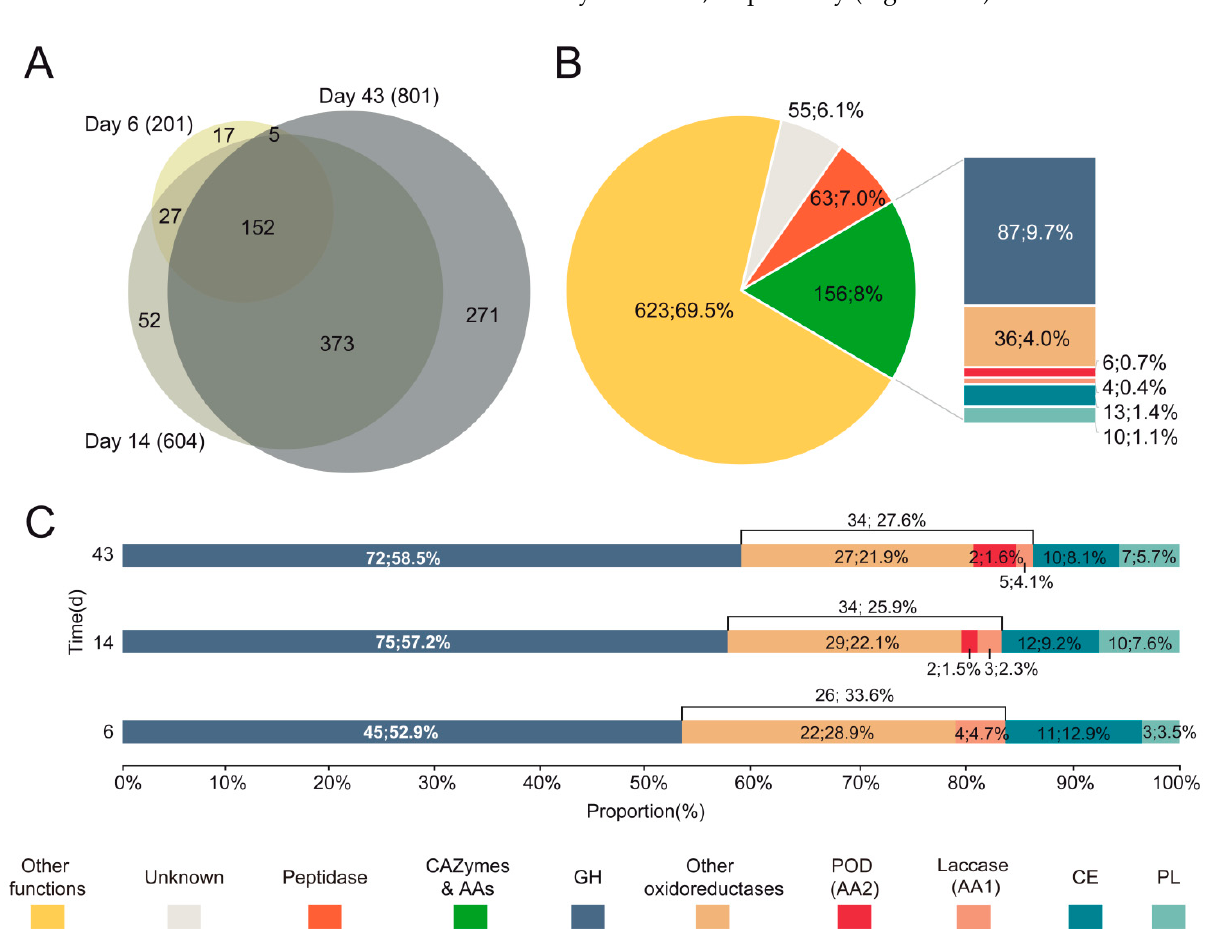
Figure 4. Functional distribution of proteins identified in the exoproteome of P. eryngii grown on wheat–straw. ( A ) Venn diagram of total protein numbers (897) after 6 (blue), 14 (red) and 43 (green) days of culture. ( B ) Distribution into functional groups. ( C ) Distribution of CAZymes and oxidoreductases on 6, 14, and 43 days of culture. The number of proteins is followed by their percentage in ( B , C ), and their predicted functions are indicated by color codes.